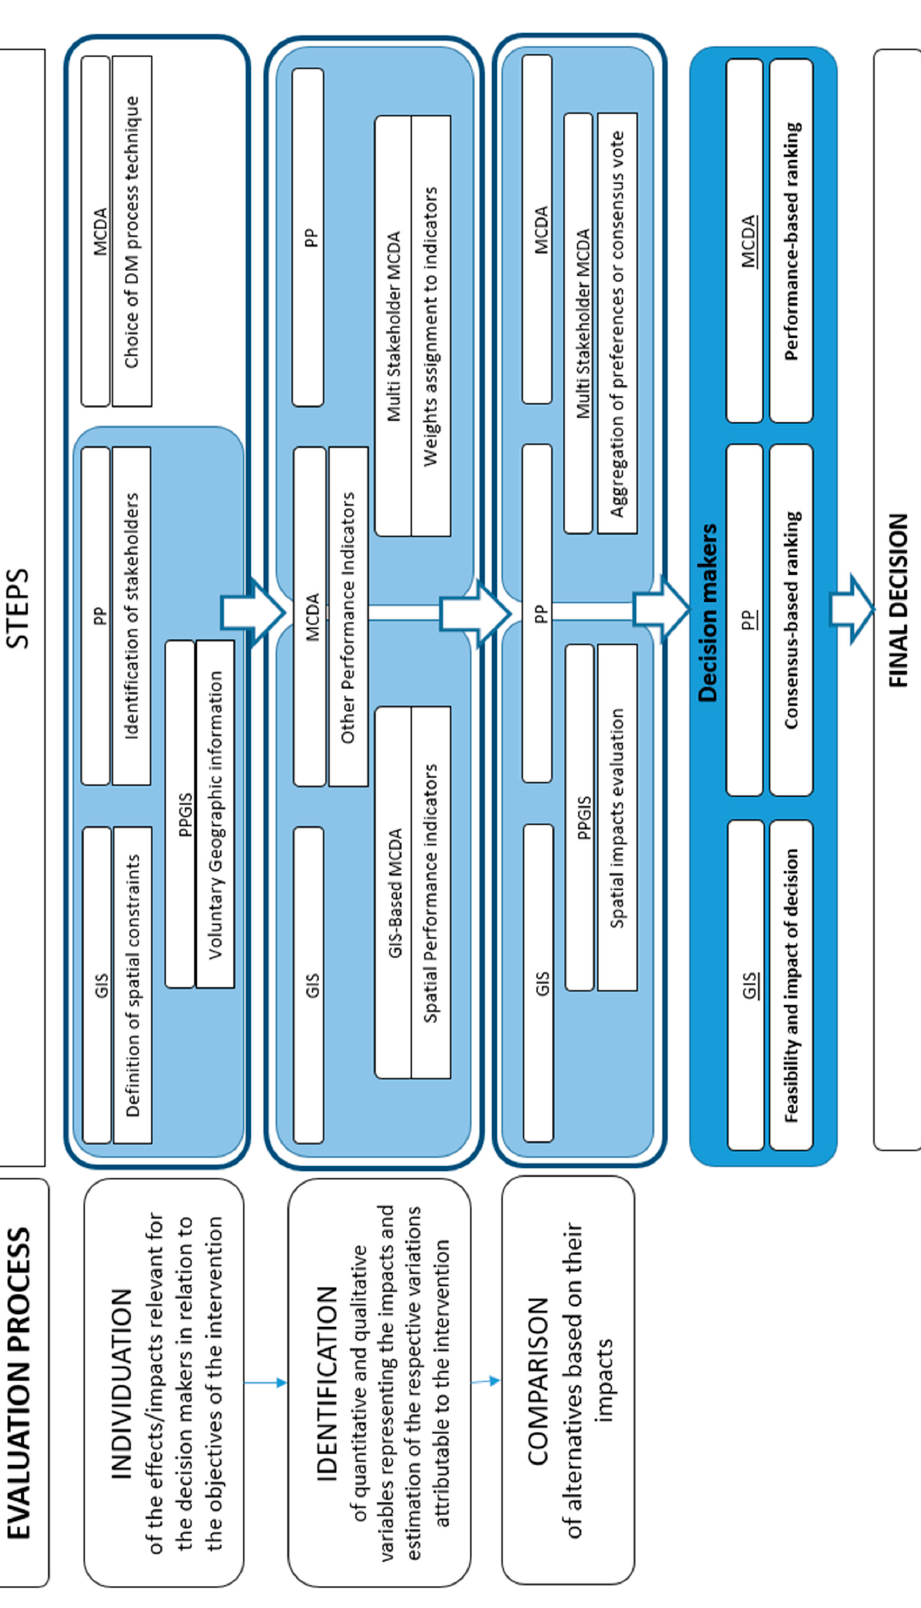
Figure 7. Framework of the contribution of GIS, MCDA and Public Participation in transport decision-making processes